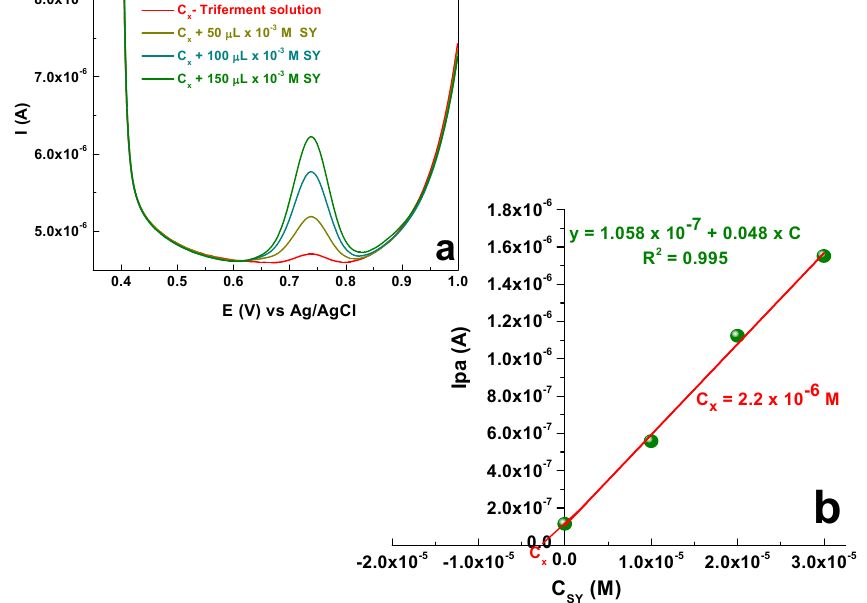
Figure 8. Square-wave voltammograms recorded with GR-exf/GC-modified electrode in Triferment solutions ( a ); the standard addition plot which allowed the determination of C x in Triferment tablet ( b ).